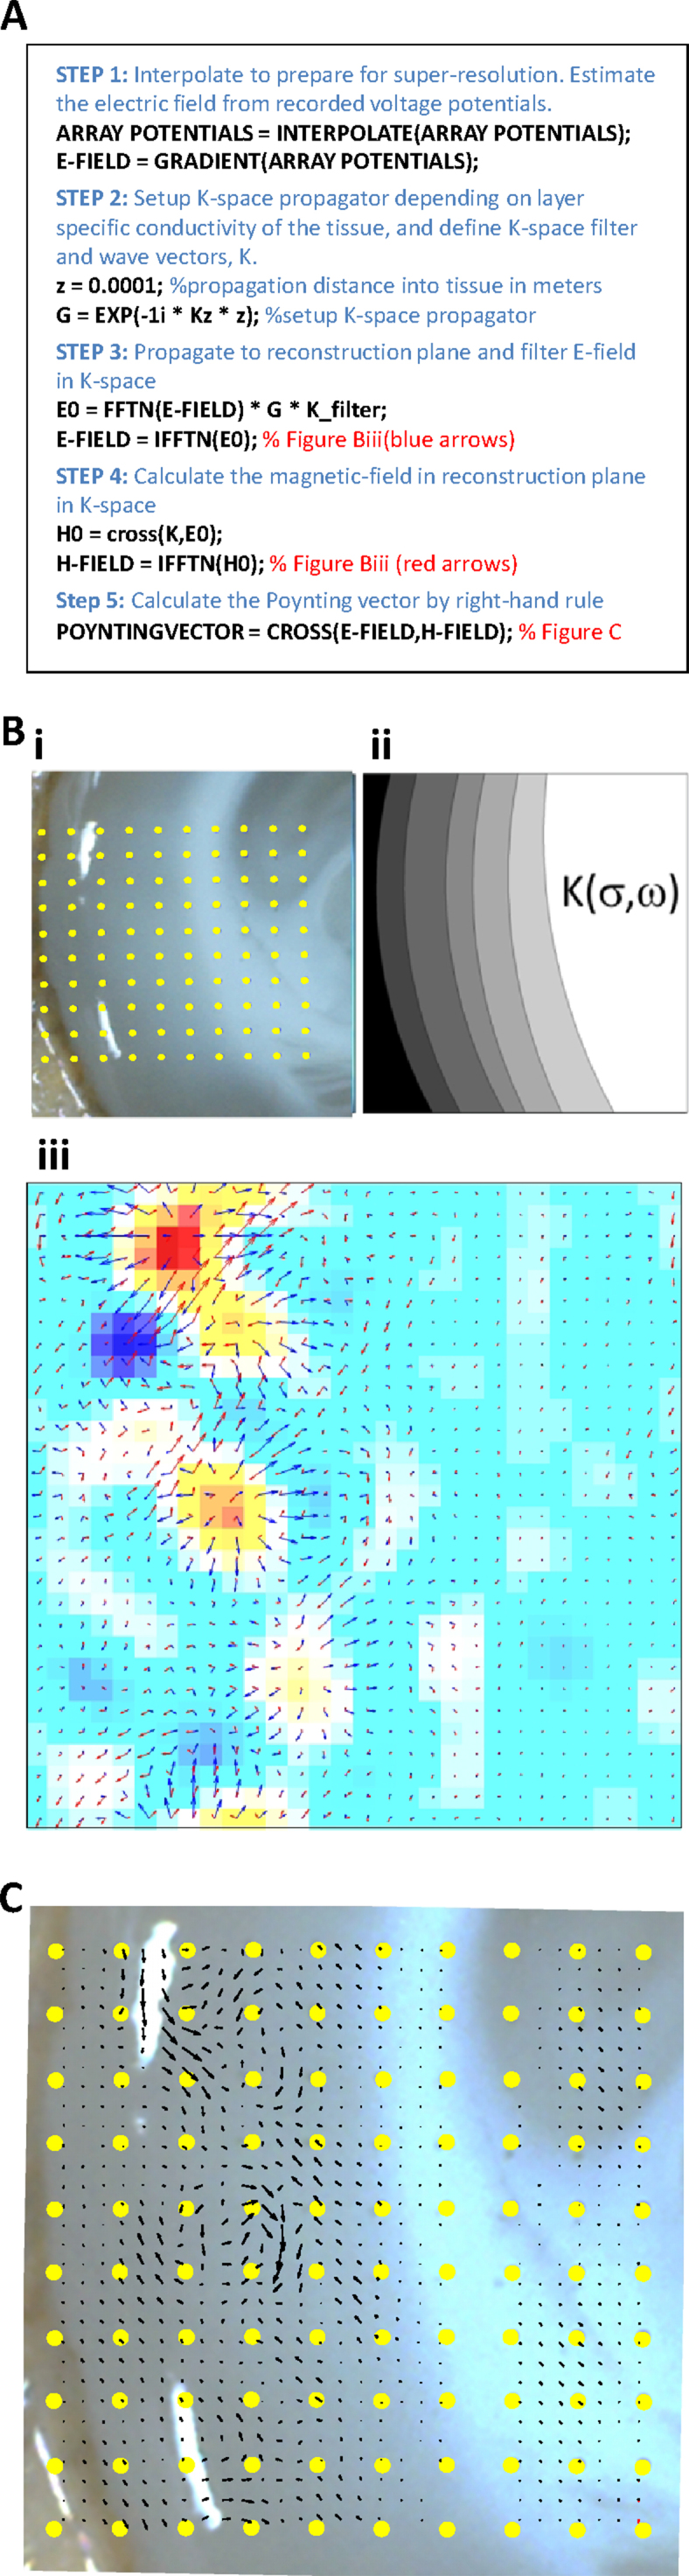
Calculating the Poynting vector from the electric (measured) and magnetic (estimated) fields. (A) Extracts of pseudocode highlighting the steps required to generate the electromagnetic energy flow in the reconstruction plane. Electric and magnetic fields were estimated at 0.1 mm (z) from the real recording plane (tissue surface) by applying a k-space propagator and filter constructed using published values of conductivity, permeability and complex permittivity through neocortex. (B). (i) The location of the real recording electrodes in the arrays used relative to a slice of neocortical tissue maintained in an interface chamber (see text). (ii) The corresponding basic structure of the layer-specific electromagnetic properties used to build the k-space filter for back-propagation. (iii) The resulting estimates of electric field (blue arrows) and magnetic field (red arrows) in the reconstruction plane (set in this example 0.1 mm from the real recording plane) overlaid on the interpolated voltages (red positive, blue negative relative to rest) taken from the recording plane. Arrow length represents local field strength, arrow direction represents local field propagation vector. (C) Overlay of the reconstructed electromagnetic energy flow in the reconstruction plane onto the array of real electrodes and the tissue recorded from. Arrows represent the local energy flow direction and intensity (angle and length of arrows, respectively). Note the strength of the electromagnetic energy flow does not map linearly onto the original recorded voltages and the units for each of the reconstructed properties plotted are arbitrary (i.e. they do not directly map onto the ‘real’ EM field properties at source). (For interpretation of the references to color in this figure legend, the reader is referred to the web version of this article.)